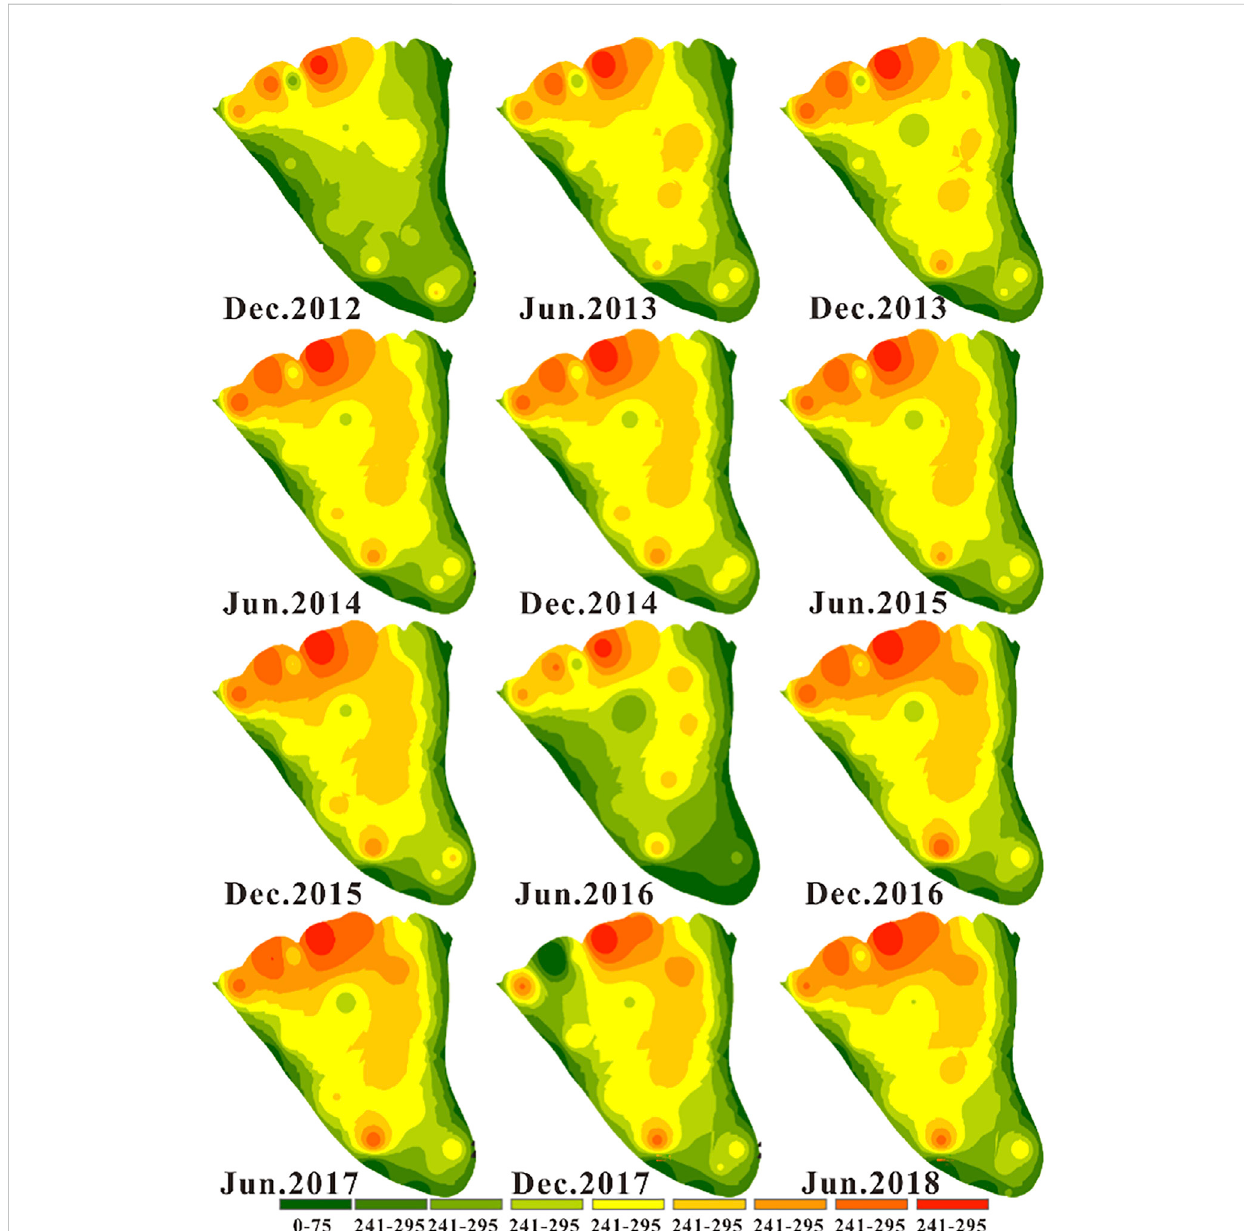
FIGURE 12 Area of strong deformation zone in total